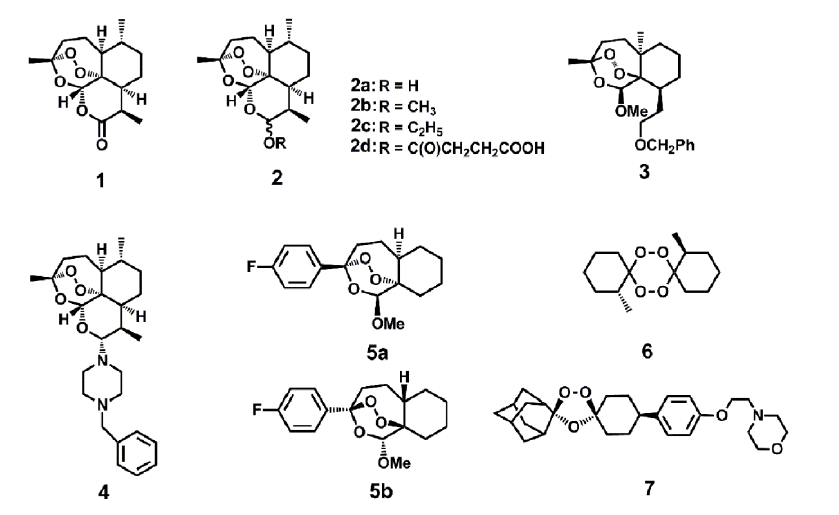
FIGURE 1: Artemisinin (ART) and some of its derivatives. The endoperoxide bond constitutes the pharmacophore for the action of ARTs. Direct ART derivatives are usually modifiers of ART at the C10 posi- tion. Some other endoperoxides differ greatly structurally but also manifest po- tent anti-malarial activities. See also refer- ences [23, 24, 25]. 1 Artemisinin. 2a Dihy- droartemisinin (DHA). 2b Artemether. 2c Arteether. 2d Artesunate. 3, 4 An analogue with close structure to artemisinin. 5a, 5b Enantiomers with similar activities against malaria parasites. 6 An antimalarial tetrao- xane. 7 OZ439 (in clinical